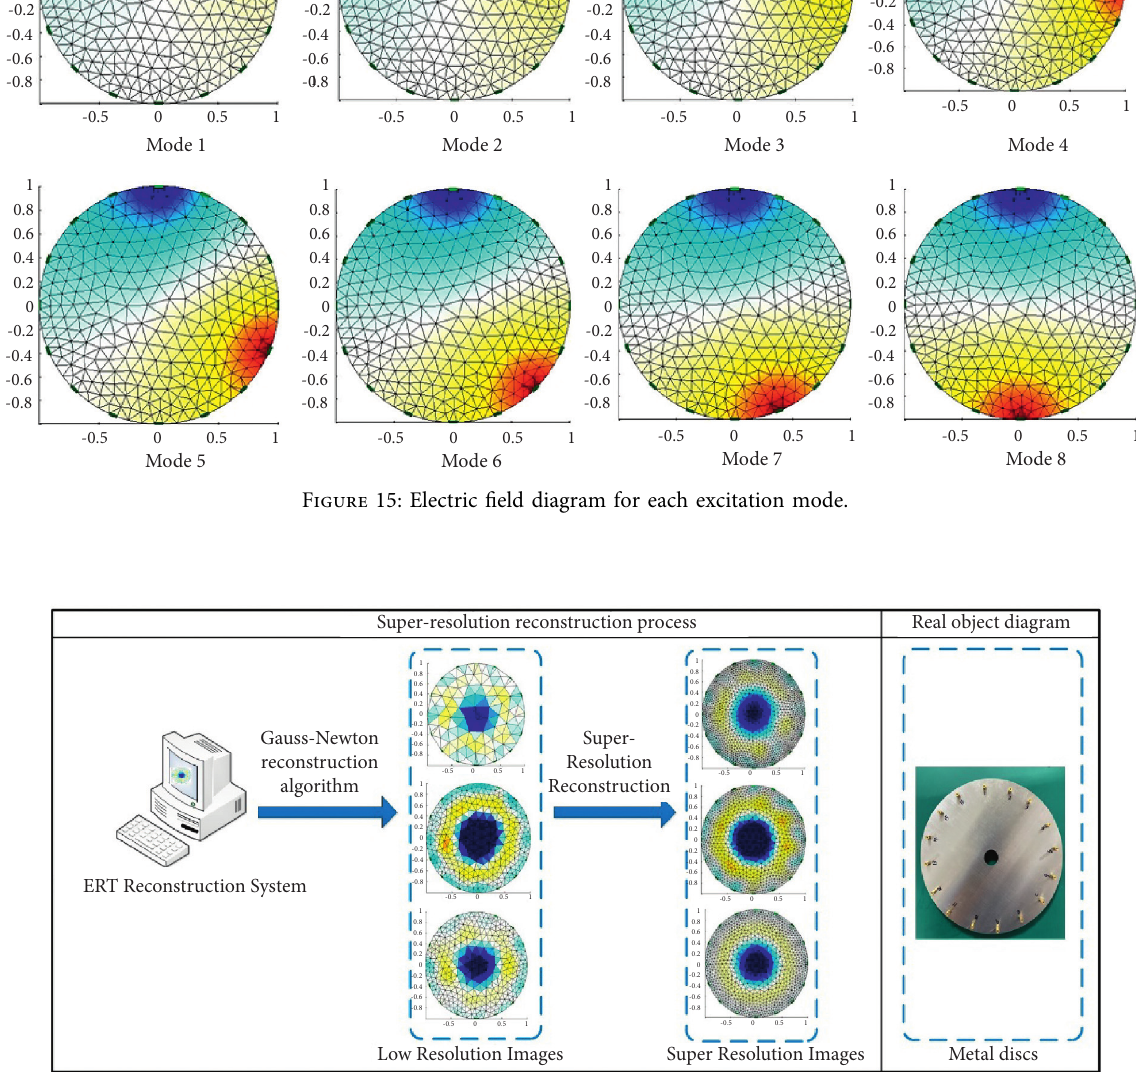
Figure 16: Super-resolution reconstruction of a perforated disc.